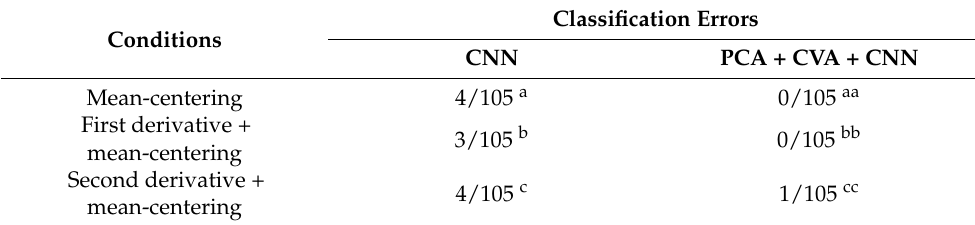
Table 3. Study #1: Prediction set classification errors (105 samples).